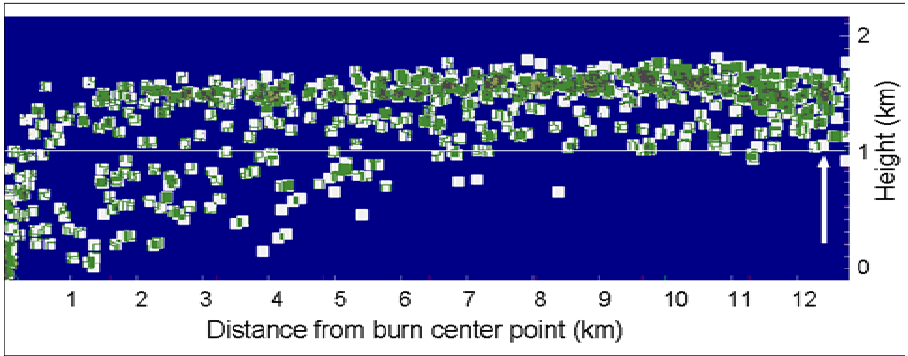
Figure 13. A projected vertical cross-section showing the Daysmoke simulation of the Block 703C burn (WRF sounding) at 12:56 LST. The mixing height is given by the horizontal white line. The “reference distance” is shown by the white